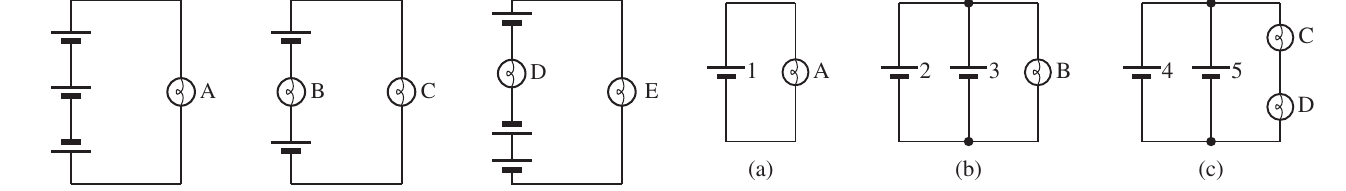
FIG. 3. Circuit diagrams used in multiple batteries in parallel pretest. Students are asked to rank the bulbs by brightness and the batteries by current, and explain their ranking.